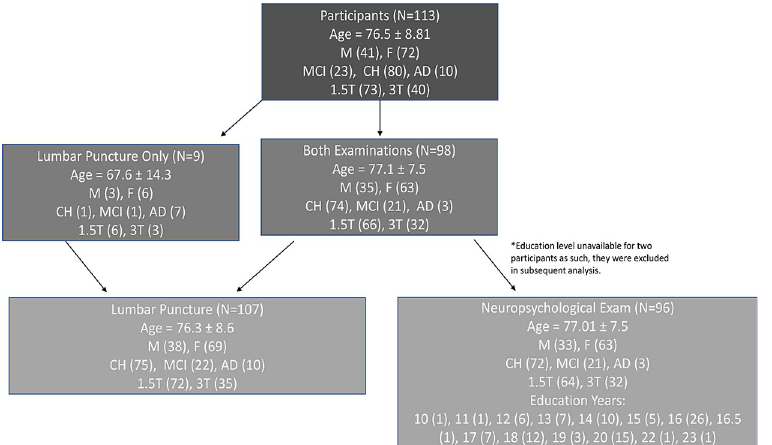
Fig 1. Cohort study design of non-exclusive subsets undergoing lumbar puncture and neuropsychological testing. Flow chart representation of participants included in this study resulting in two non-exclusive subsets. M = Male, F = Female, CH = Cognitively Healthy, MCI = Mild Cognitive Impairment, AD = Alzheimer’s disease, 1.5T = GE Signa HDx 1.5T scanner, 3T = GE Signa HDx 3T scanner.